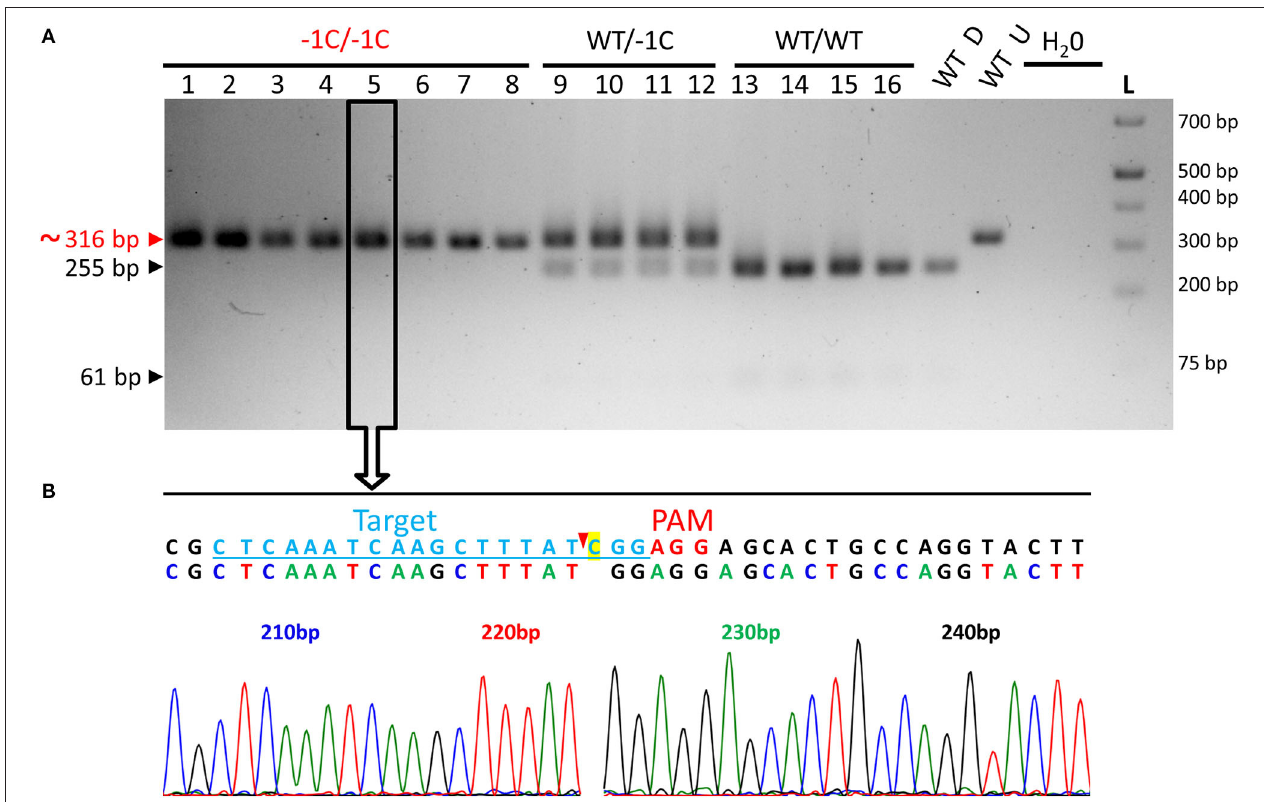
FIGURE 9 | Genotyping of the embryos extirpated from the grains of WT/ − 1C plants for the on-target mutations in the HvMPK6 gene - representative results. (A) PCR-RE genotyping. Mature T3-generation grains of heterozygous transgenic plants and mature grains of WT non-transgenic control plants were imbibed in Milli-Q water at 21 ◦ C in darkness for 18 or 24h before embryo extirpation and subsequent analysis. Following embryo extirpation and imaging, genomic DNA was extracted from the morphologically abnormal and morphologically normal embryos and/or the respective endosperms with most of the intact bran of transgenic grains and also from the same material of control WT grains. About 316-bp PCR amplicons of the genomic region covering the on-target site, which were associated with eight abnormal and eight normal transgenic embryos were digested with Hpy 188I. The red arrowhead and red typing of the size of the PCR product indicate the undigested PCR amplicons contaning mutation which disrupts the Hpy 188I recognition site. The black arrowheads and black typing of the sizes of the PCR products indicate the digested WT PCR amplicons. Wt D—digested and Wt U—undigested reference 316-bp amplicons associated with an endosperm with most of the bran of a WT grain. L-O’GeneRuler 1kb Plus DNA Ladder (Thermo Fisher Scientific, Waltham, MA, USA). Sizes of the selected ladder fragments are shown on the right. Eight abnormal embryos were homozygous knockout mutants in the HvMPK6 gene ( − 1C/ − 1C) four normal embryos were heterozygotes (WT/ − 1C), and four normal embryos were WT (WT/WT). Selected PCR amplicons were also sequenced (an example for a − 1C/ − 1C mutant in an open rectangle with an arrow). (B) Single sequencing chromatogram associated with the − 1C/ − 1C embryo. Above the chromatogram, deduced color-coded nucleotide sequence and reference WT nucleotide sequence including the position of the on-target site (underlined lightly blue typing) and the PAM site (red typing) are shown. The nucleotide numbering is shown as the distance in bp from the first nucleotide of the K6E3_F1 primer site. Cas9 endonuclease from S. pyogenes cleaves target DNA sequences most frequently after the third nucleotide upstream of a PAM site (Jinek et al., 2012; Ran et al., 2015) (red arrowhead). Single base pair CG deletion (“C” highlighted in yellow in a reference sequence) occurs next to the cleavage site in the third nucleotide position upstream of the PAM site. Deduced nucleotide sequence corresponds to the WT nucleotide sequence except for the CG